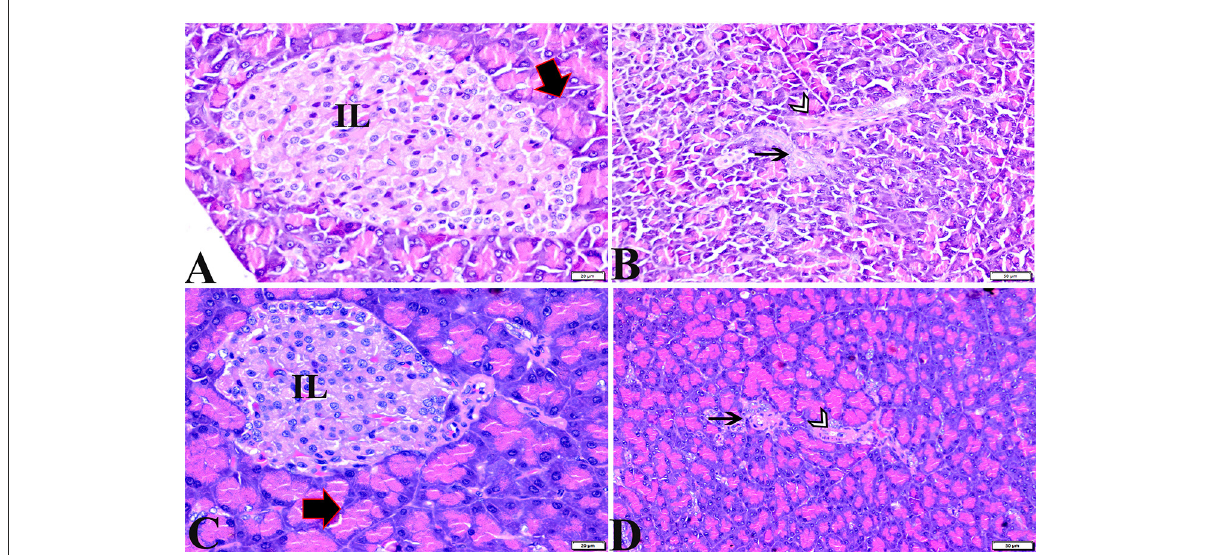
FIGURE1 Photomicrographs of pancreatic sections from the control negative group (A,B) and the MT control group (C,D) demonstrating normal pancreatic structure and architecture in the form of normal-sized islets of Langerhans and normal density of islet cells, normal exocrine acinar cells (thick arrows), a normal intralobular duct (arrowheads), and normal blood vessels (thin arrows). H&E stained. The bar size is indicated under each picture.